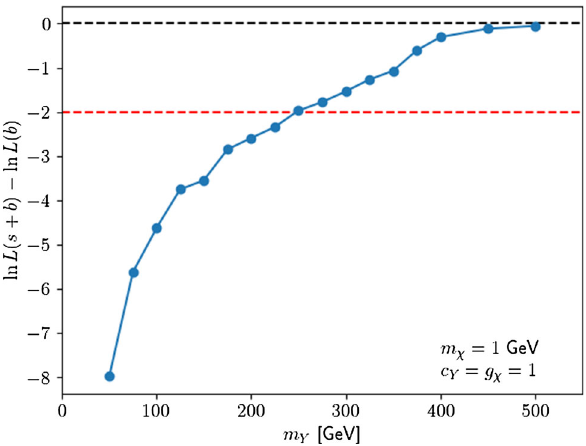
Fig. 6 The log-likelihood contribution Δ ln L = ln L ( s + b ) − ln L ( b ) from a simulation of the ATLAS search in Ref. [112] in a scan of the mediator mass m Y in the MDMSM. The mediator coupling to SM particles ( c Y ) and to DM ( g χ ) are set to c Y = g χ = 1, and the DM mass is fixed at m χ = 1 GeV. The dashed black line denotes Δ ln L = 0, i.e. the limit where the signal plus background prediction fits the data equally as well as the background-only prediction. The dashed red line at Δ ln L = − 2showsthe Δ ln L limitcorrespondingtoa2 σ confidence intervalon m Y .Themostsensitivesignalregiondiffersforthe m Y = 50 GeV point, but is otherwise consistent across the